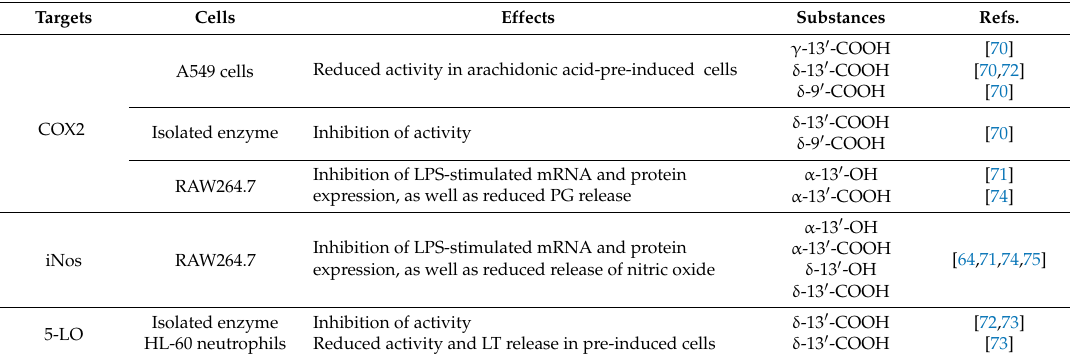
Table 1. Overview of anti-inflammatory actions of the LCMs of vitamin